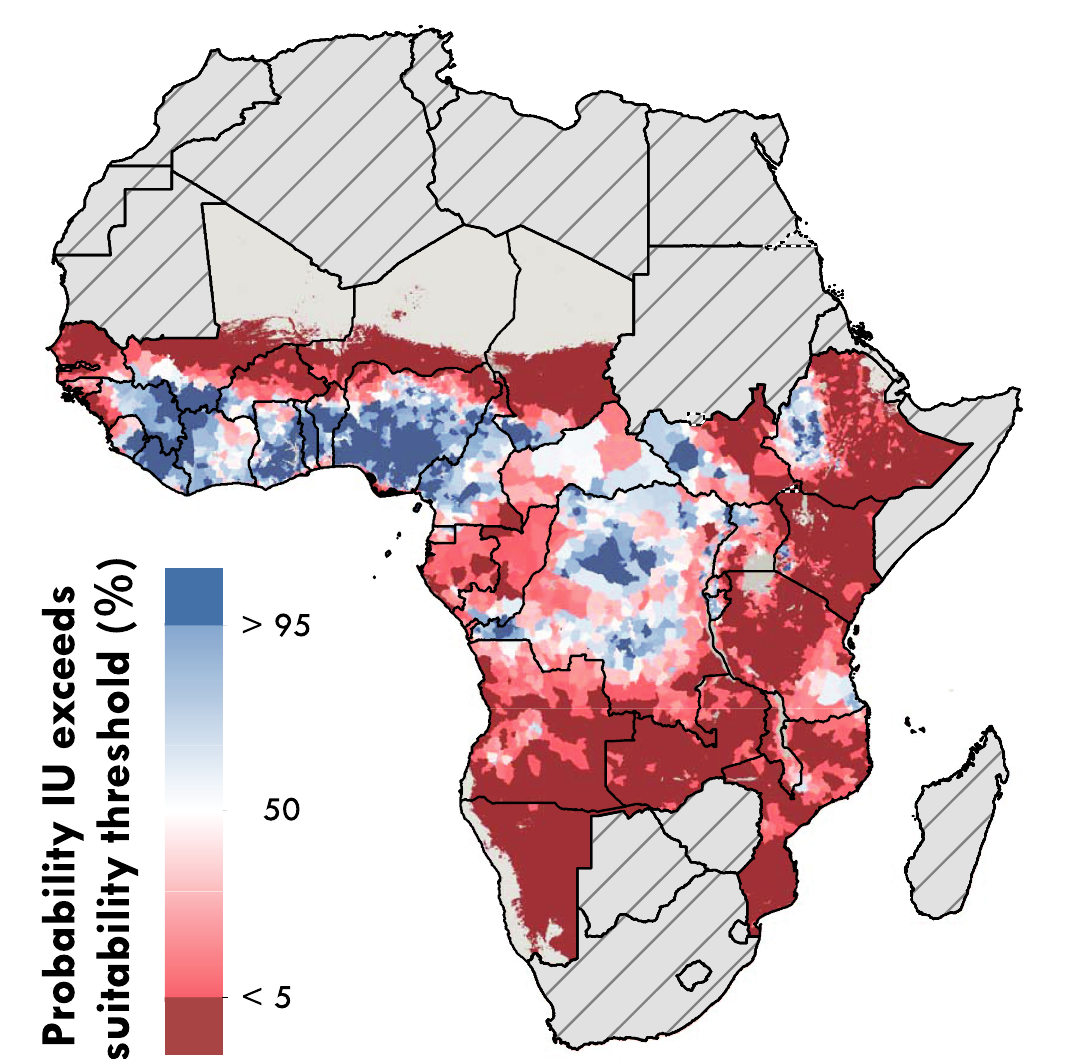
Fig 3. Posterior probability any location with Implementation Units (IU) exceeds the threshold for suitability. The posterior probability (%) of an IU including a location that exceeds the 0 � 71 threshold used to identify areas of suitability is estimated from the 100 BRT bootstraps. Areas in red are less likely to have at least one location defined as suitable, areas in blue are more likley to include environmentally suitable locations. Countries in grey with hatch marks were excluded from the analysis based on a review of national endemicity status. Areas in grey only represent locations masked due to sparse population. Maps were produced using ArcGIS Desktop 10.6 and shapefiles to visualize administrative units are available at https://espen.afro.who.int/tools-resources/cartography-